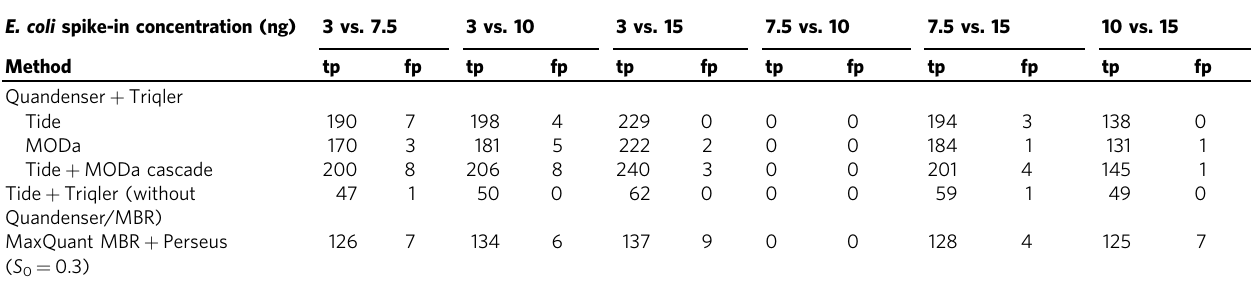
Table 2 Benchmark on the Shalit HeLa + E. coli data